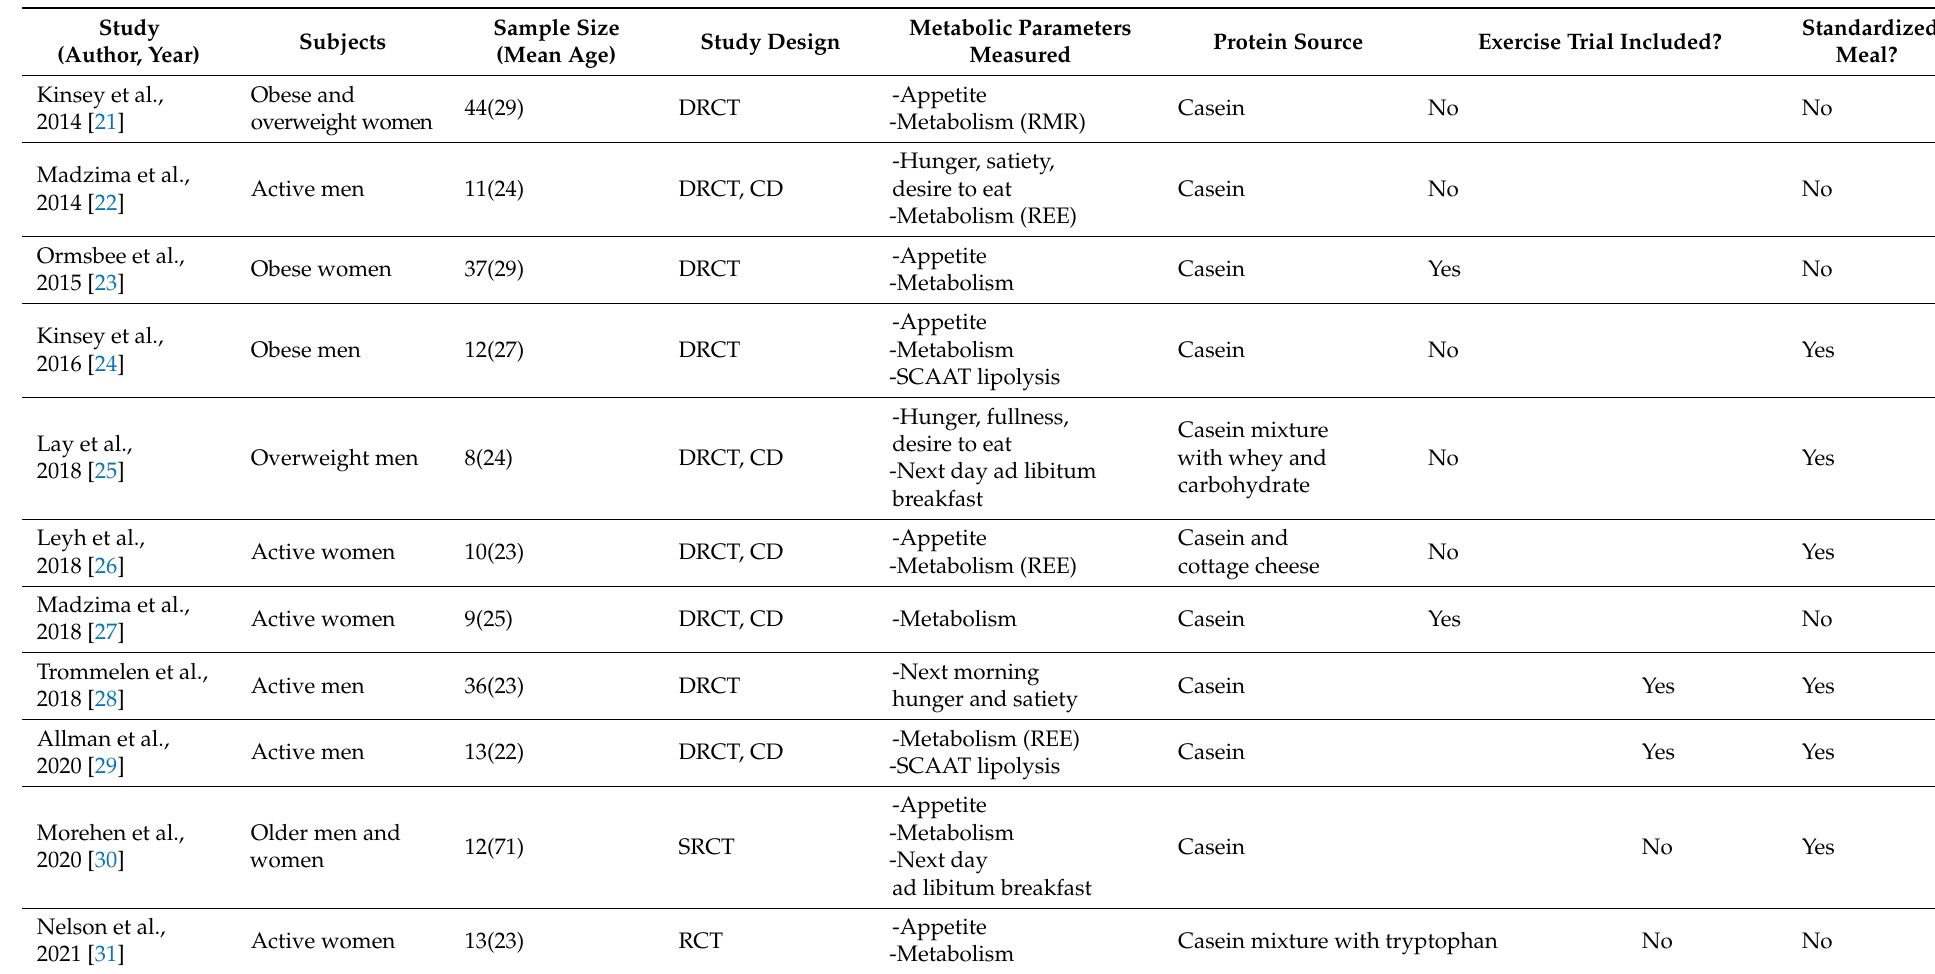
Table 2. Main characteristics of included studies related to pre-sleep casein supplementation effects on metabolism and